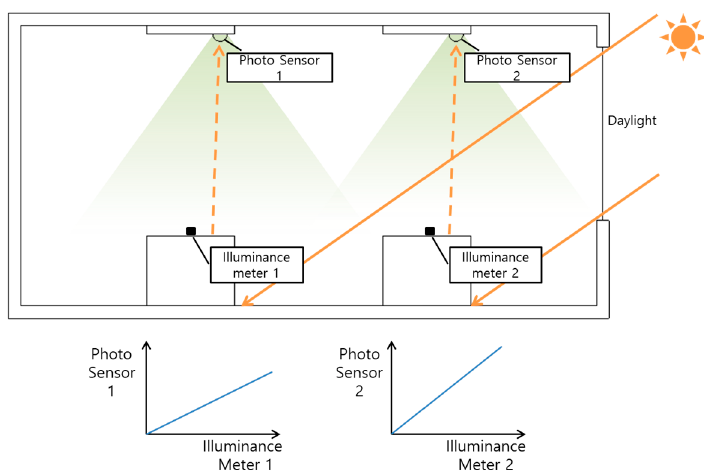
Figure 2. Learning method of the daylight illuminance on the workplane prediction algorithm.